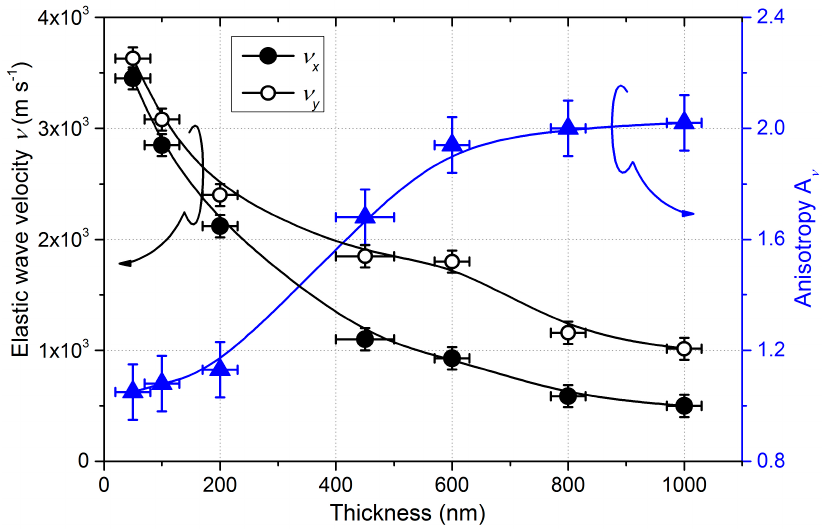
Figure 5. Group velocities of pseudo-Rayleigh waves along x and y -axes, and related anisotropic coefficient as a function of the W film’s thickness.